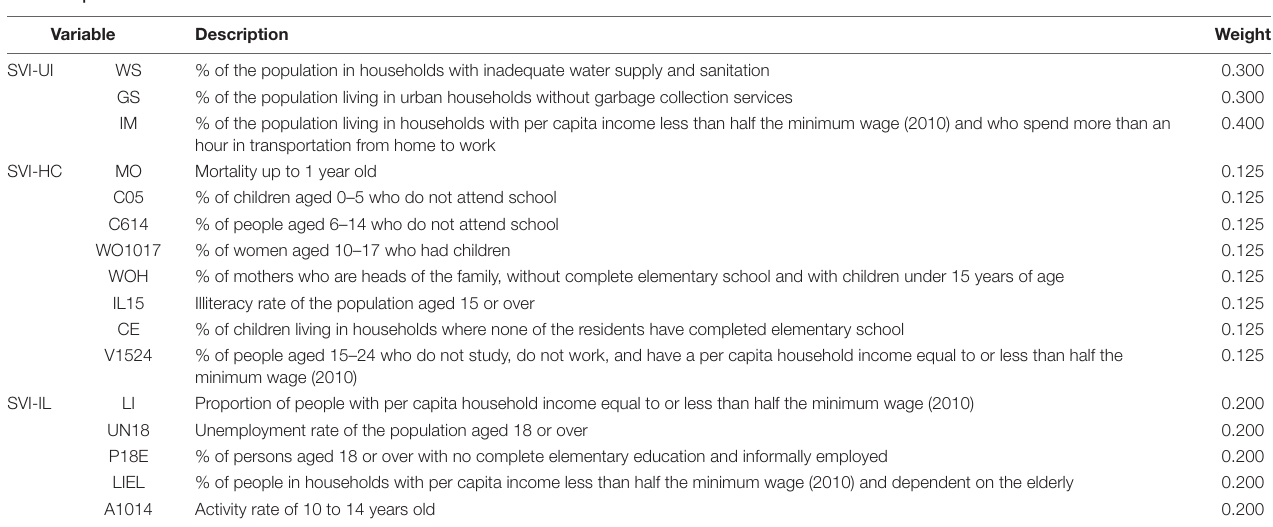
TABLE 2 | The indicators and dimensions of